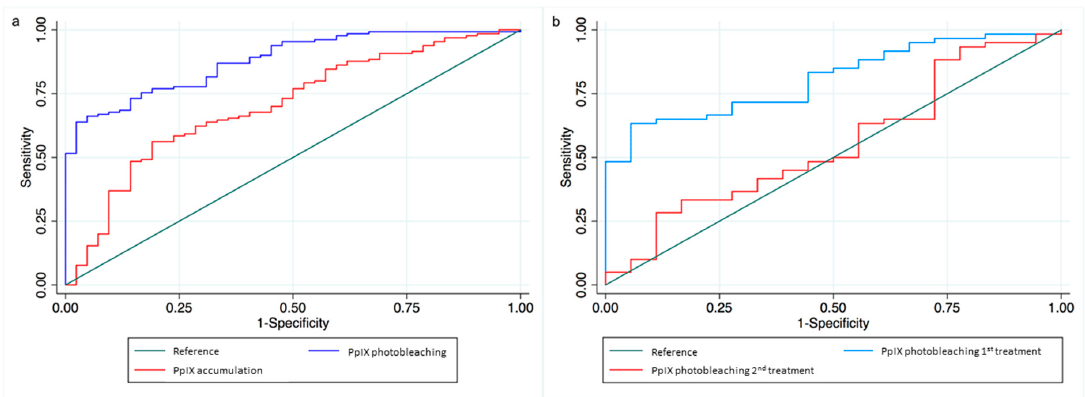
clinical outcome at 3 months more successfully than PpIX accumulation. Area under curve (AUC) is 0.88 for PpIX photobleaching and 0.69 for PpIX accumulation and ( b ) ROC curve for first and second treatment PpIX photobleaching in the patients undergoing two treatments 9 days apart. AUC indicates first treatment PpIX photobleaching is a better predictor of clinical outcome (0.81 versus